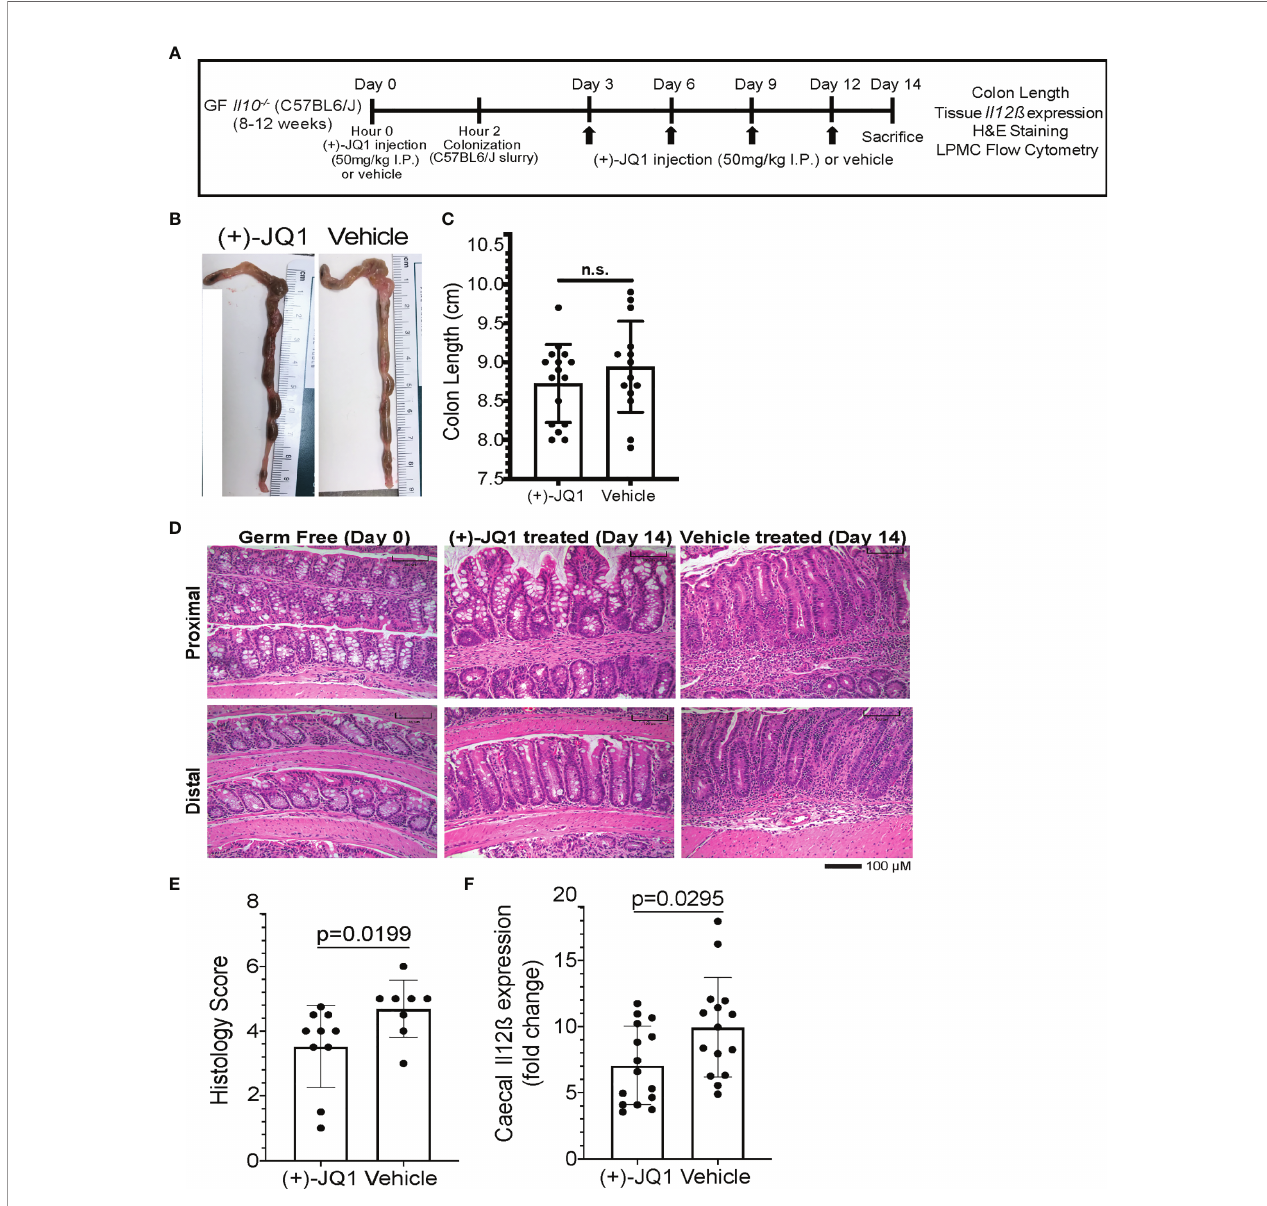
FIGURE 4 | (+)-JQ1 treatment attenuates onset of microbiota-induced colitis in germ free Il10 -/- mice. (A) Schematic of experimental work fl ow (n = 10+ mice/condition and represent at least 3 independent experiments). (B) Representative images of colon length and thickness in (+)-JQ1- and vehicle-treated mice. (C) Quanti fi cation of average colon length (n = 16 (+)-JQ1; n = 15 vehicle). (D) Representative images of H&E stained colons for proximal (top) and distal (bottom) portions of the colon in germ free (GF) mice (left), colonized mice treated with (+)-JQ1 harvested on Day 14 (center) and colonized mice treated with vehicle harvested on Day 14 (right). Scale represents 100 µM. (E) Quanti fi cation of histology scores based on H&E staining (n = 10 (+)-JQ1; n=8 vehicle). (F) Quanti fi cation of caecal Il12 b expression by qPCR (n = 15/treatment). Signi fi cance values determined using a 2-tailed unpaired, non-parametric student ’ s t test. N.S. stands for Not Signi fi